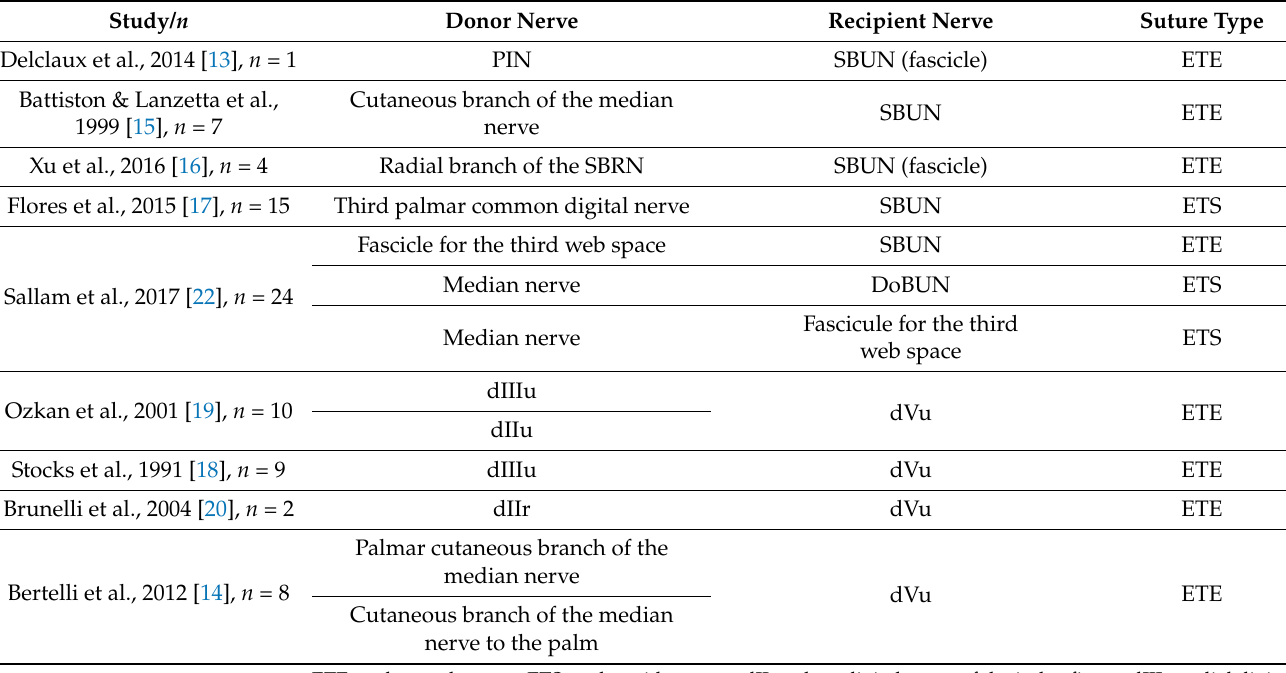
Table 3. Surgical